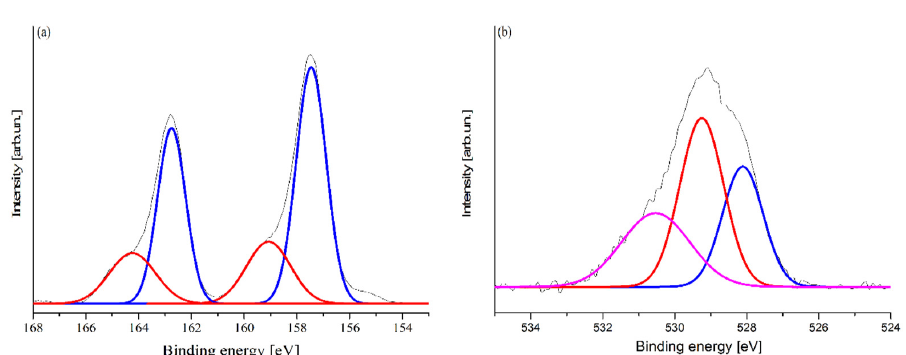
Figure 3. Magnification of high-resolution XPS spectra of synthesized Bi 2 O 3 in the region ( a ) of Bi 4f 7/2 -Bi 4f 5/2 (154–168 eV) and ( b ) O 1s (524–534 eV). Purple, red, and blue curves represent the peaks components.